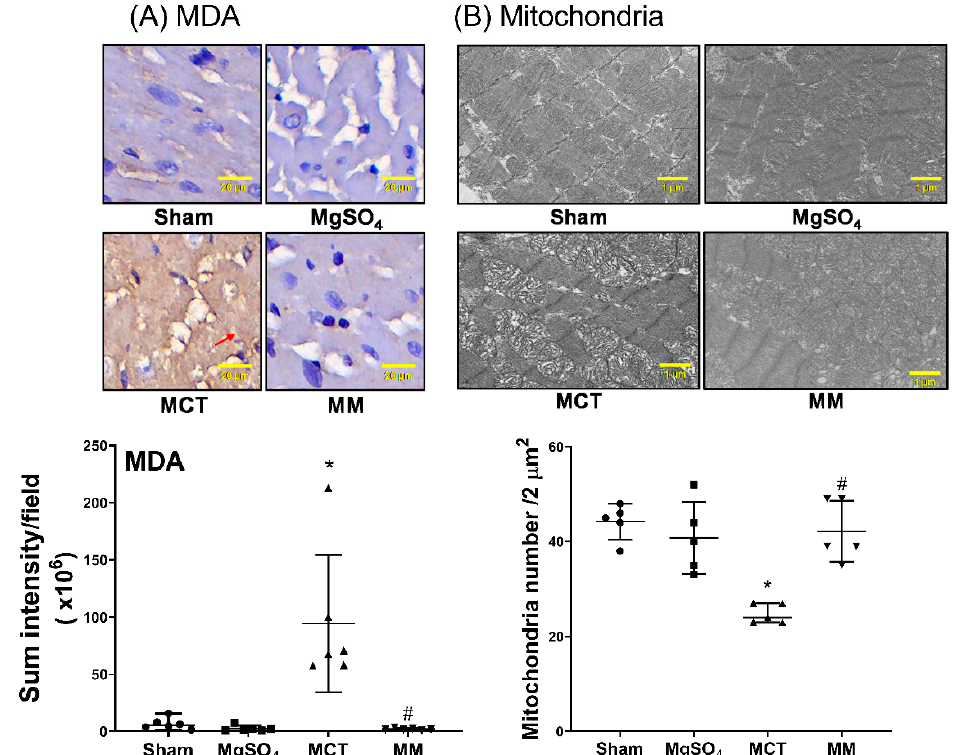
Figure 6. Magnesium sulfate (MgSO 4 ) mitigates monocrotaline-induced lipid peroxidation and mitochondrial injury in the right ventricular myocardium. ( A ) Representative microscopic images of malondialdehyde (MDA, the end product of lipid peroxidation) in the right ventricular myocardium obtained using an immunohistochemistry staining assay (200 × ). The red arrow indicates the representative image of MDA with brown color staining. The quantitative sum intensities of MDA are presented. ( B ) Representative transmission electron microscopic images of mitochondria in the right ventricular myocardium (8000 × ). Mean intact mitochondria numbers (per 2 µ m 2 ) are presented. Sham: normal saline group. MgOS 4 : MgSO 4 (100 mg / kg / day) group. MCT: monocrotaline (60 mg / kg) group. MM: monocrotaline (60 mg / kg) plus MgSO 4 (100 mg / kg / day) group. Data are expressed as median (range). Data of MDA and mitochondria were obtained from six and five rats from each group, respectively. * p < 0.05 versus the sham group. # p < 0.05 versus the MCT group.